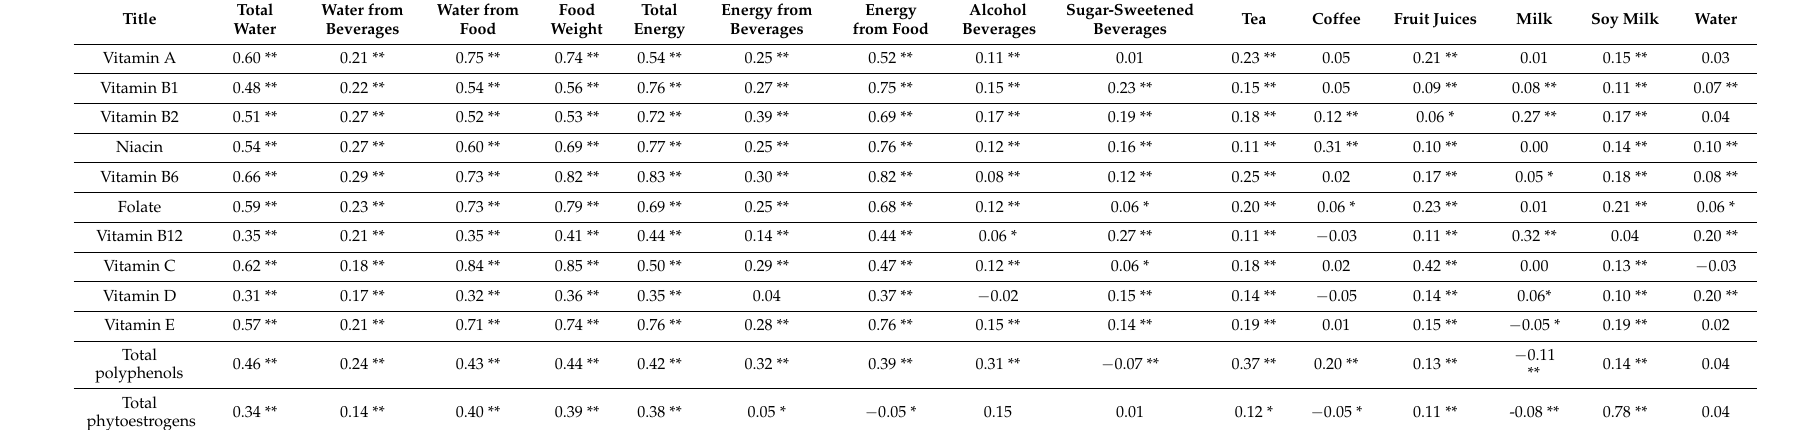
Table 6. Partial correlations between water intake, energy intake, beverage consumption, vitamins and